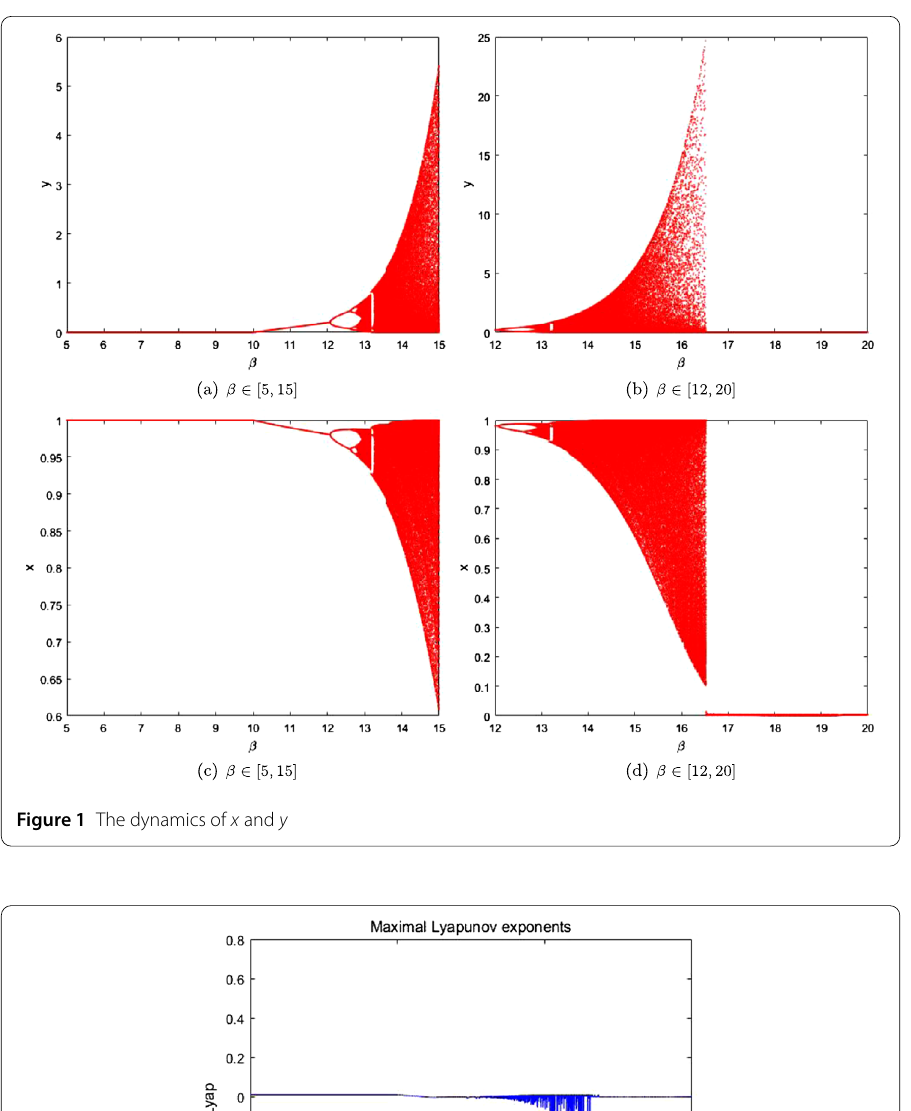
Figure 2 Maximum Lyapunov exponents corresponding to Fig.